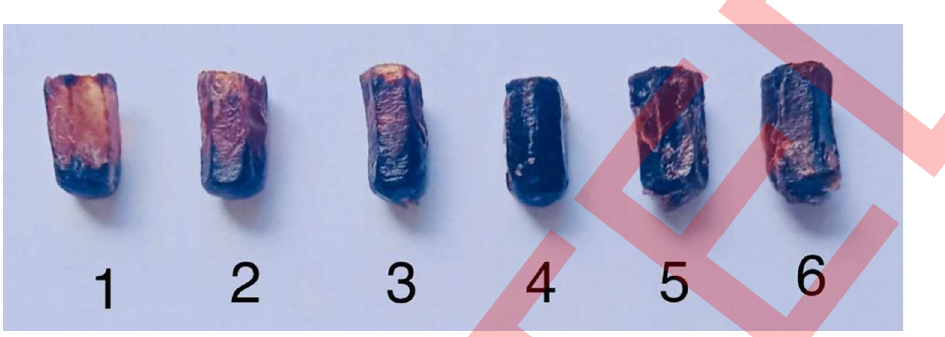
Fig 2. The accumulated substances in a cell in combs of different ages.